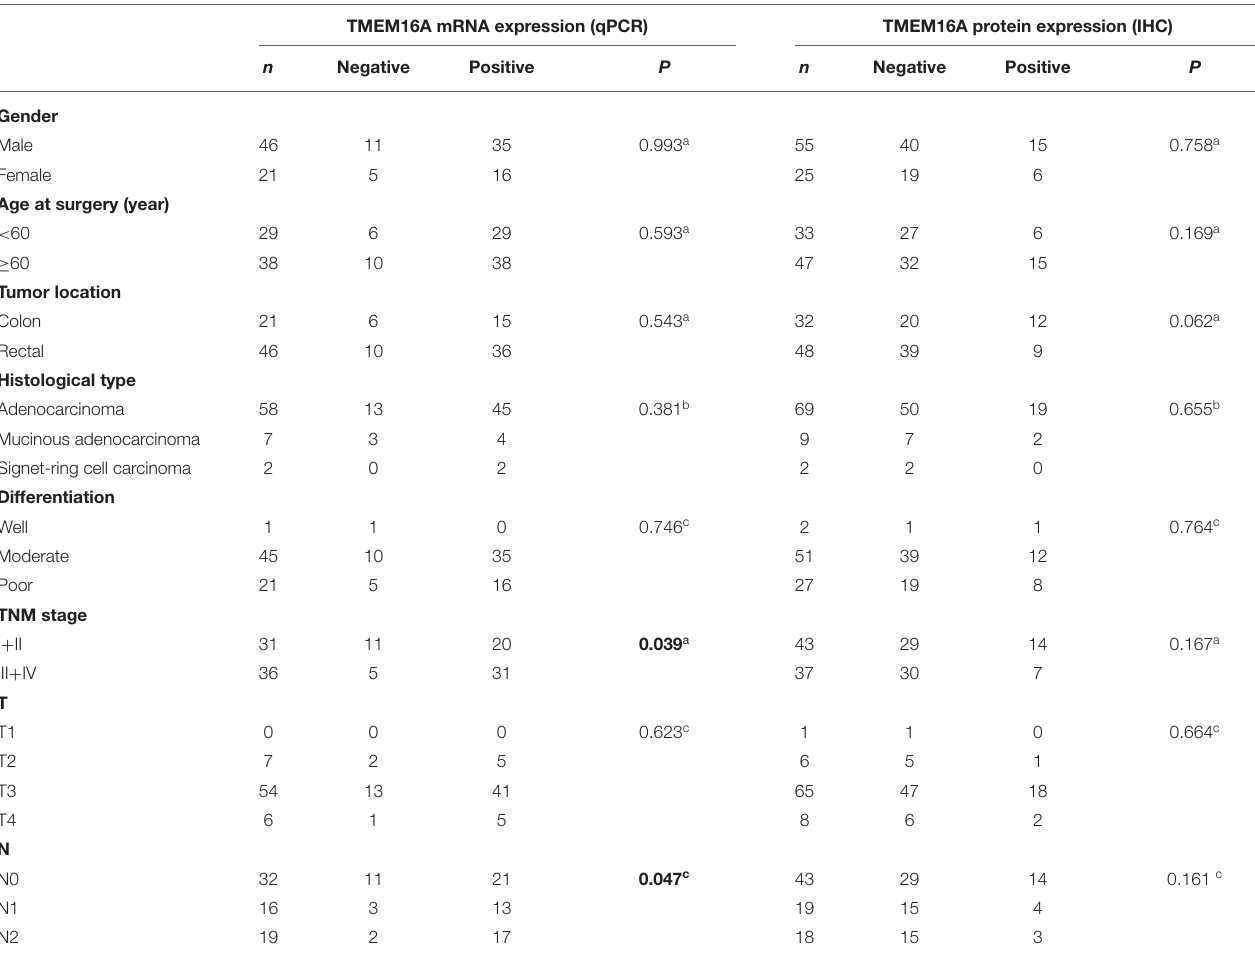
TABLE 3 | Associations between TMEM16A expression and clinical features in